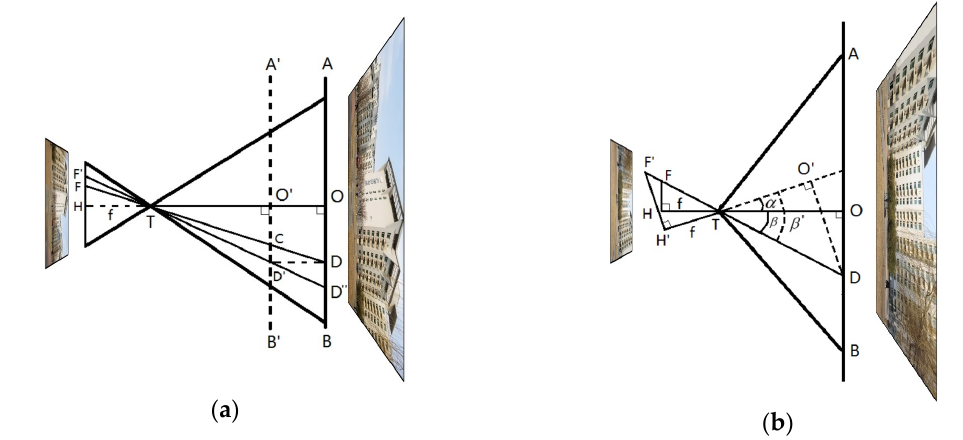
Figure 8. Projection models of the camera. T is the optical center of the camera. D represents a key point on scene plane AB and F is the projected point on the CCD (image) plane. f is the focal length. ( a ) Camera moves forward, | OO (cid:48) | is the moving distance; ( b ) camera rotates, α is the rotation